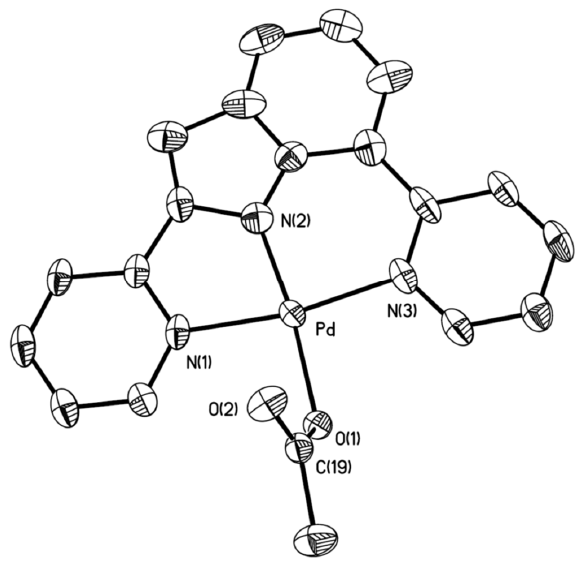
Figure 2. Molecular structure of 3 with thermal ellipsoids drawn at the 30% probability level. Selected bond lengths (Å) and bond angles ( ◦ ): Pd-N(1), 2.043(4); Pd-N(2), 1.941(6); Pd-N(3), 2.055(5); Pd-O(1), 2.045(4); N(2)-Pd-N(1), 78.0(2); N(2)-Pd-N(3), 90.8(2); N(1)-Pd-N(3), 168.7(2); N(1)-Pd-O(1), 95.22(18); N(2)-Pd-O(1), 173.23(18); O(1)-Pd-N(3), 96.0(2). Hydrogen atoms omitted for clarity.